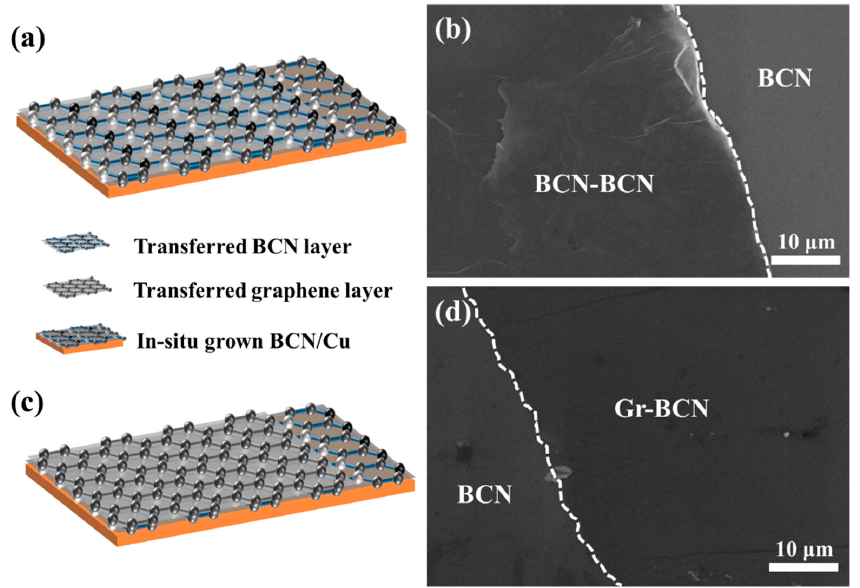
Figure 3. ( a ) Schematic diagram of BCN-BCN sample; ( b ) SEM of BCN-BCN sample; ( c ) Schematic diagram of BCN-Gr sample; ( d ) SEM of BCN-Gr sample.